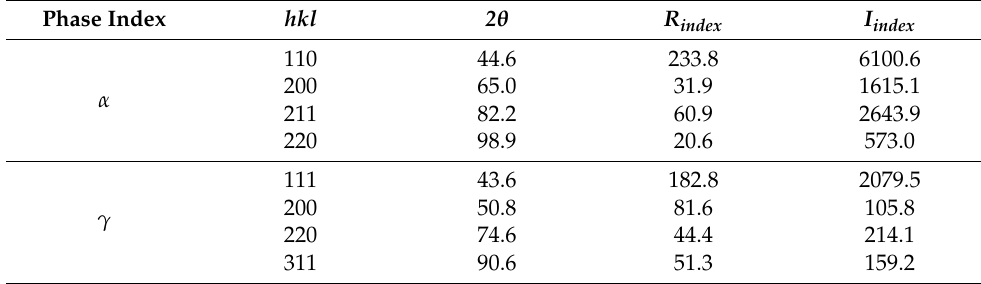
Figure 7. X-ray diffractogram patterns from the as-received CR980XG3 TM steel. Table 1 presents the calculated R α and R γ values for Cu radiation and the integrated intensity per angular diffraction peak. Each peak was fitted with the Lorentz fit peak tool available in the OriginLab software. From Equation (1) and Table 1 data, the estimated volume fraction of the retained austenite in the present CR980XG3 TM steel sheet is 12.2%, which was very close to the value of ~12% reported for the Q&P 980 steel [19,20]. Table 1. Theoretical R α and R γ using Cu radiation (data from [41]) and integrated intensity per angular